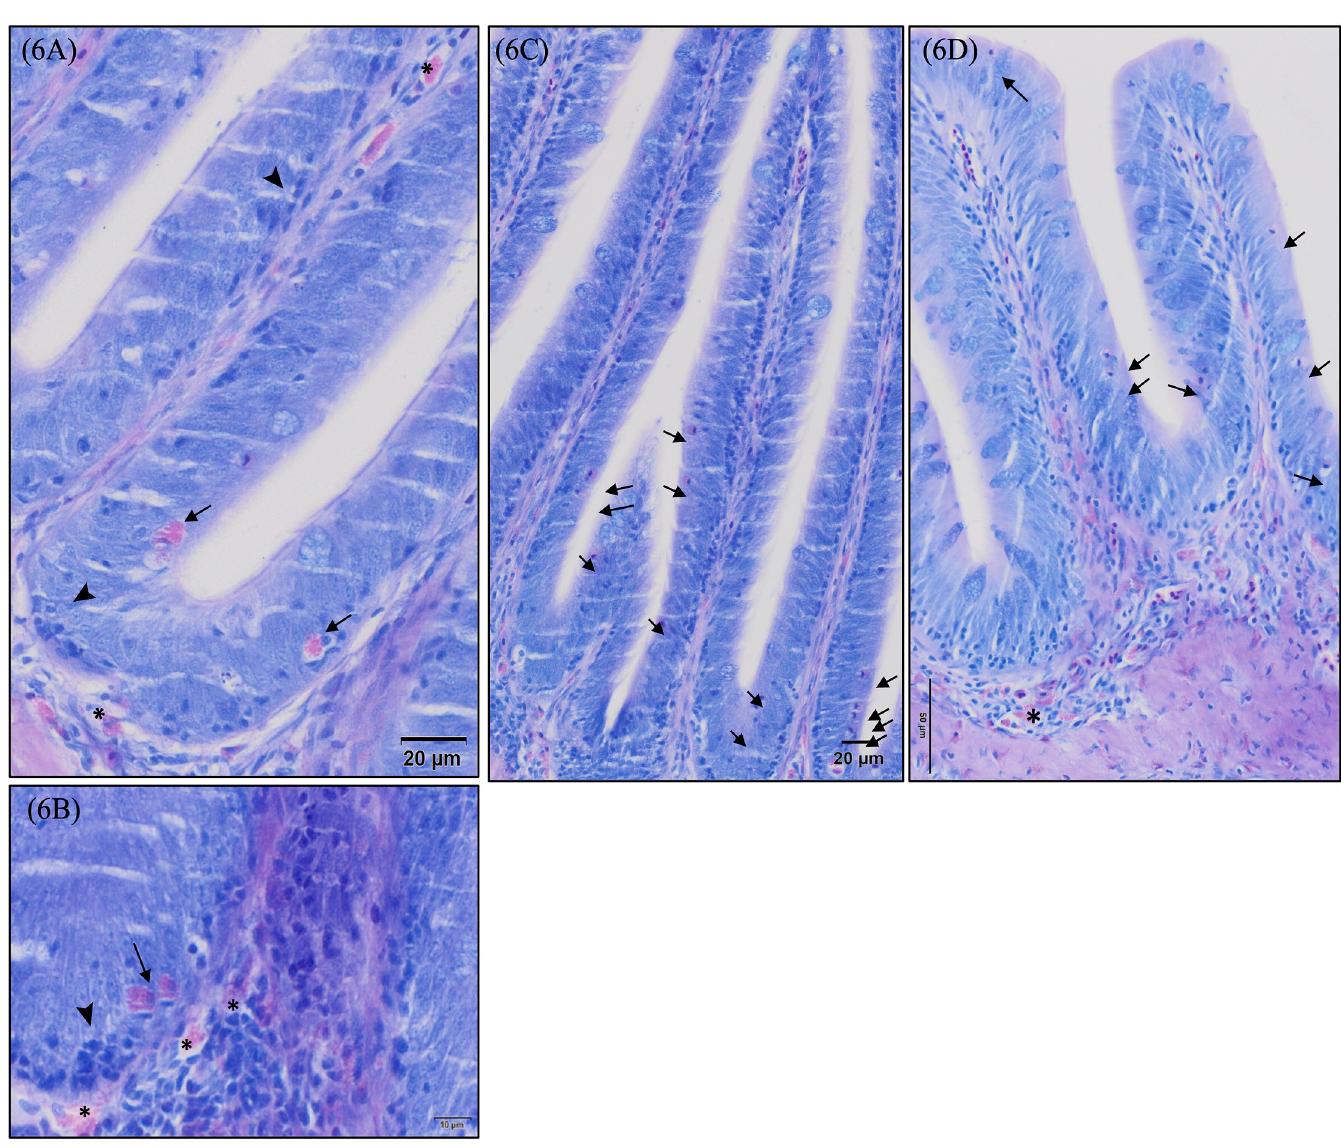
Fig 6. Detailed micrographs of infiltrated granulocytes and lymphocytes and rodlet cells present in European sea bass ( Dicentrarchus labrax ) intestinal mucosa stained with May-Gru¨nwald Giemsa. (6A) Detail of infiltrated granulocytes in the rectum mucosa ( ! ), submucosa and lamina propia ( � ). Infiltrated lymphocytes are indicated by ➤ . Scale bar 20 μ m. (6B) Detail of infiltrated granulocytes ( ! ) and lymphocytes ( ➤ ) in posterior gut mucosa. Observe the mixed population of leukocytes in the submucosa. Granulocytes are indicated by ( � ). Scale bar 10 μ m. Observe the higher density of rodlet cells present in the basal region of the fold compared to the apical region in rectum (6C) and posterior gut (6D). Scale bar 50 μ m- 20 μ m.